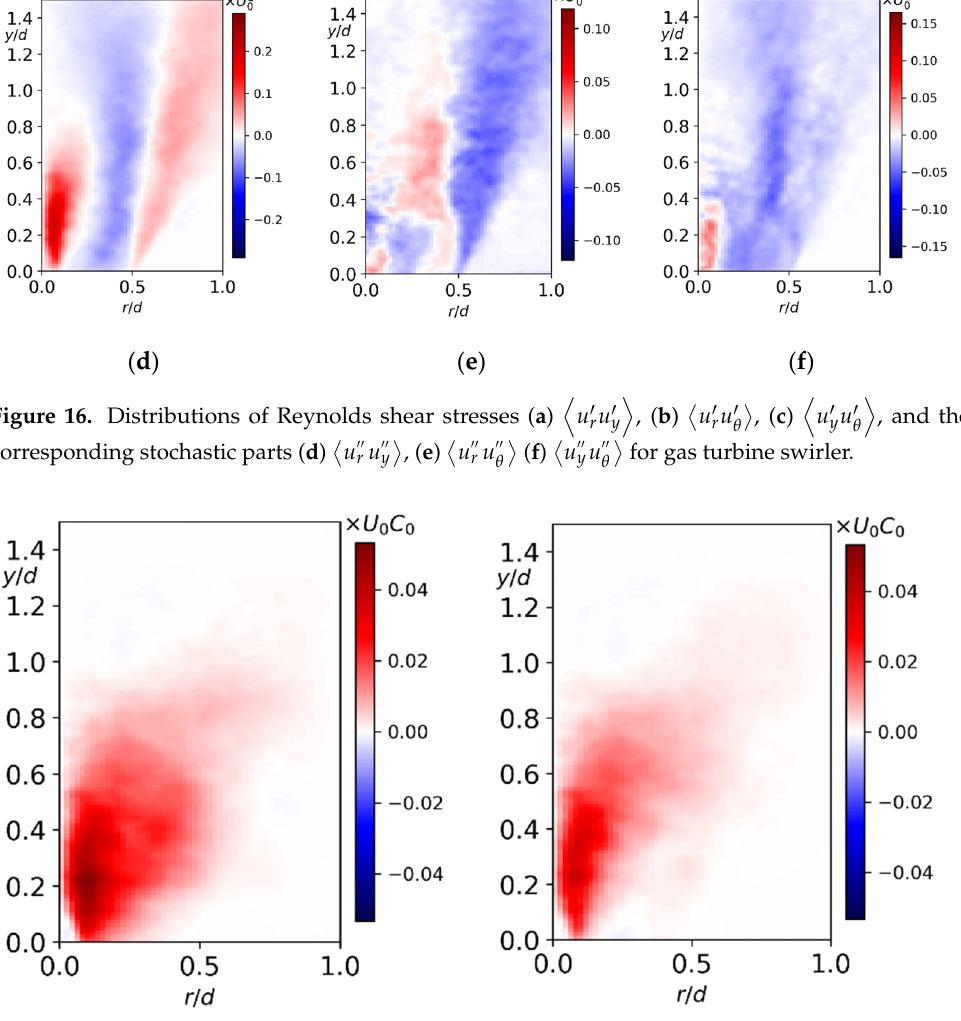
Figure 17. Radial turbulent flux of methane for ( a ) total and ( b ) stochastic turbulent fluctuations for gas turbine swirler.